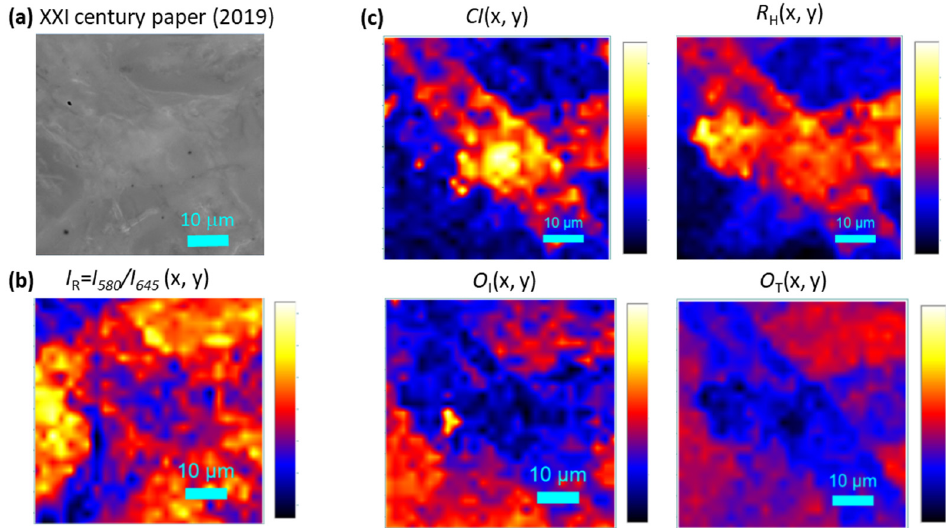
Figure 3. ( a ) White light optical image (objective 100 × ) of 60 × 60 µ m 2 of non-exposed paper sample area selected for spectra acquisition. Maps from 2D spectral arrays of (30 × 30) complete Raman/luminescence spectra recorded in the spectral imaging mode and extracted using as contrast parameters ( b ) the ratio I R between the luminescence peak intensities and ( c ) the CI , R H , O I and O T markers from Raman spectra. The color code displays the increasing value in the sequence blue–red–yellow.